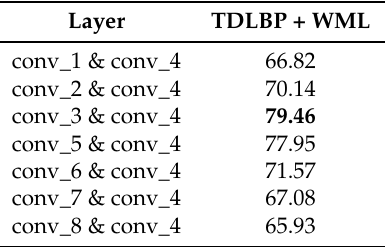
Table 9. The performance of TDLBP + WML in combinations of two convolutional layers.